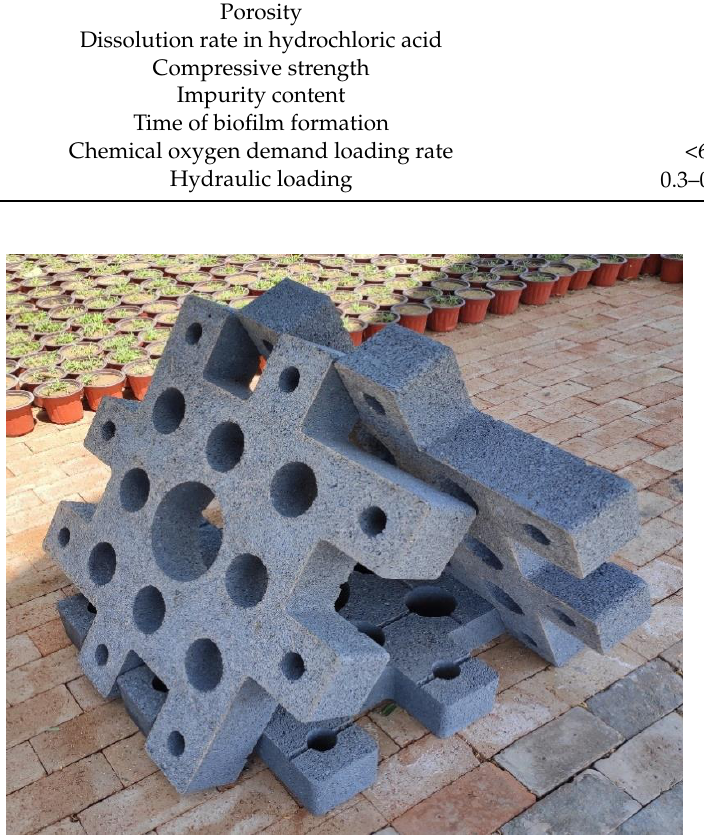
Figure 3. Real view of the artificial reef.